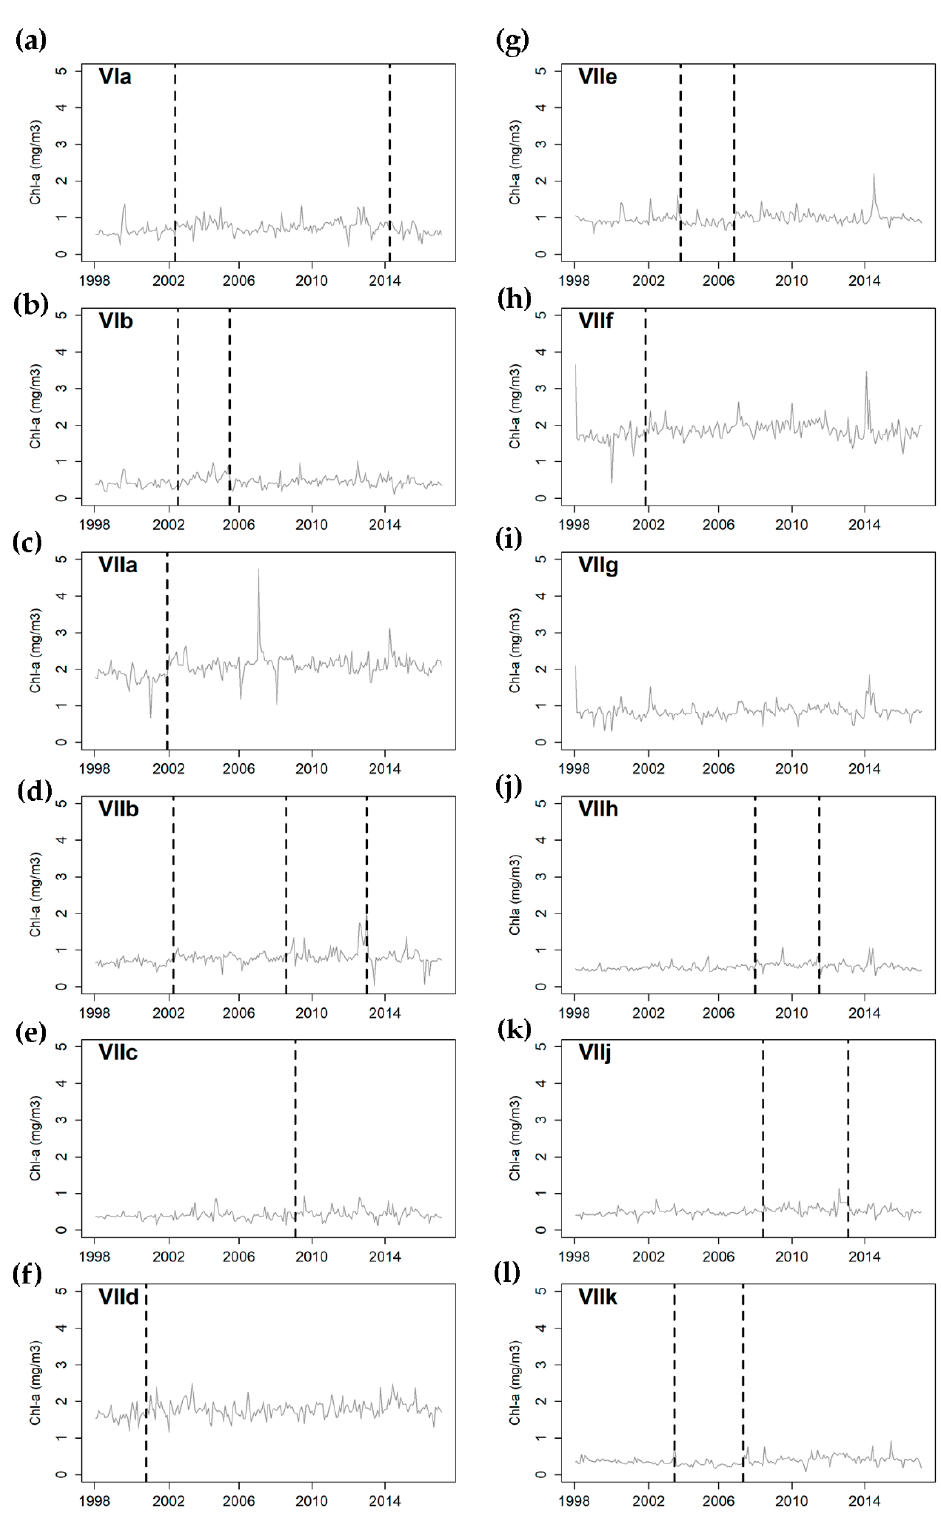
Figure 5. Seasonally adjusted chlorophyll (Chl-a) time series for each ICES division. Structural breakpoints were identified in the following dates: ( a ) May 2002 and February 2014; ( b ) July 2002 and May 2005; ( c ) December 2001; ( d ) April 2002, June 2008; ( e ) December 2008; ( f ) October 2000; ( g ) October 2003 and September 2006; ( h ) October 2001; ( i ) no breakpoints; (j) November 2007; ( k ) April 2008 and December 2012; ( l ) June 2003, March 2007.